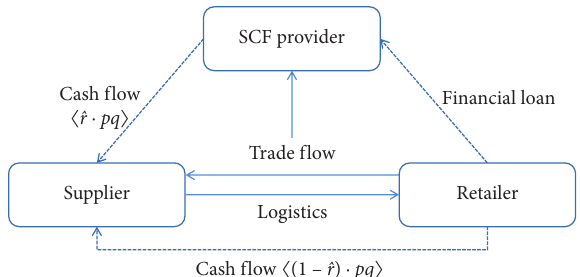
Figure 1: SCF transaction structure of the two-echelon supply chain.